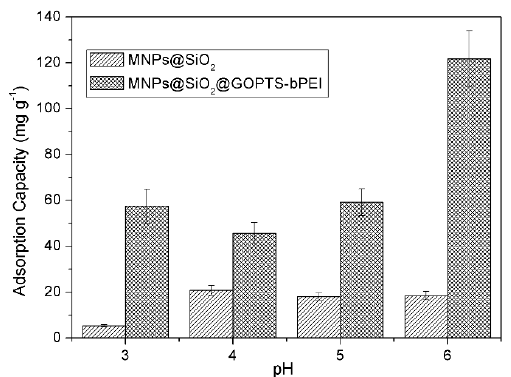
Figure 4. Influence of solution pH on adsorption capacity of Cu 2+ for MNPs@SiO 2 and GOPTS-bPEI modified MNPs@SiO 2 .